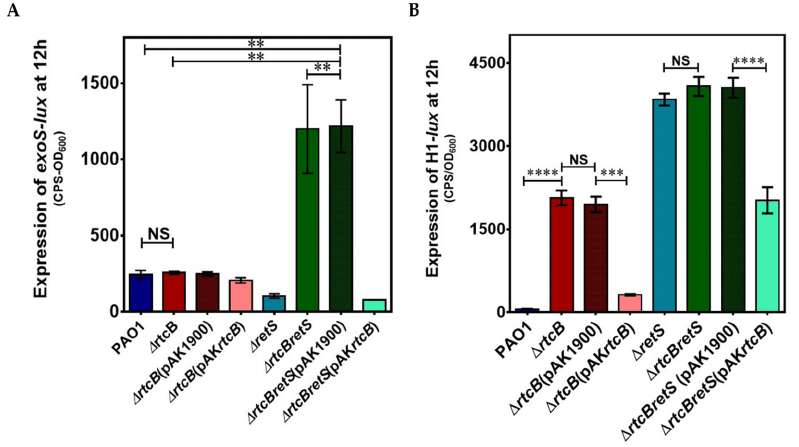
Figure 2. The promoter activities of exoS ( A ), an effector of T3SS, and H1-T6SS ( B ) in PAO1 and its derivative mutants at the 12 h growth time point. CTX-H1 and CTX- exoS reporter fusions were integrated into the chromosome of P. aeruginosa. Complementing vector pAK1900- rtcB was introduced to the mutant strains PAO1( ∆ rtcB ) and PAO1( ∆ rtcB ∆ retS ), respectively, to construct the complementation strains. Expression is reported as light production (counts per second) normalized to growth (OD 600 ). The results shown are the average of three independent readouts performed in triplicate. Data were analyzed using one-way ANOVA with Dunnette post-hoc test. NS p > 0.05, ** p < 0.01, *** p < 0.001, and **** p <